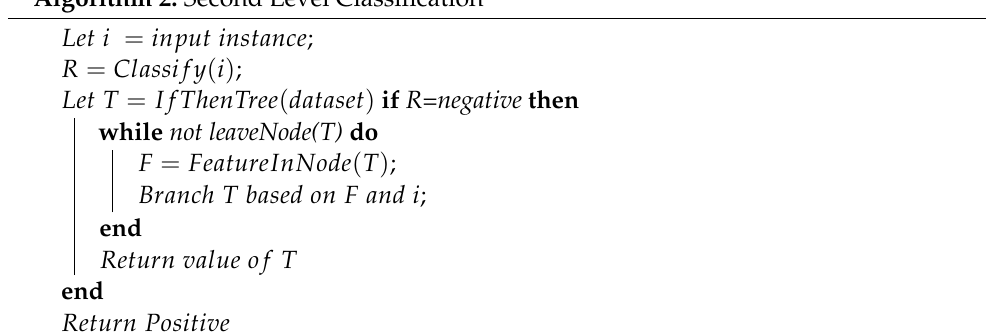
Algorithm 2: Second Level Classification